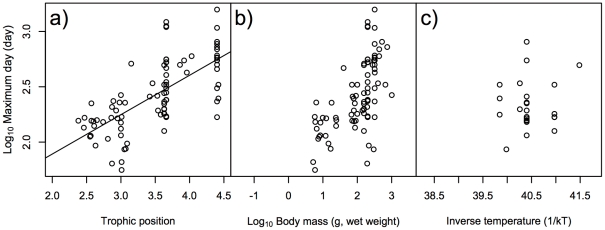
Effects of ecological/biological traits of species on maximum day of 137Cs activity concentration in fish.Effects of a) trophic position of species, b) body mass (g, wet weight) of species, and c) inverse temperature (1/kT) of the environment on log10 maximum day (day) of 137Cs activity concentration in fish. Line indicates a significant relationship by the best GLMM, with the coefficient and intercept estimated by GLMM.